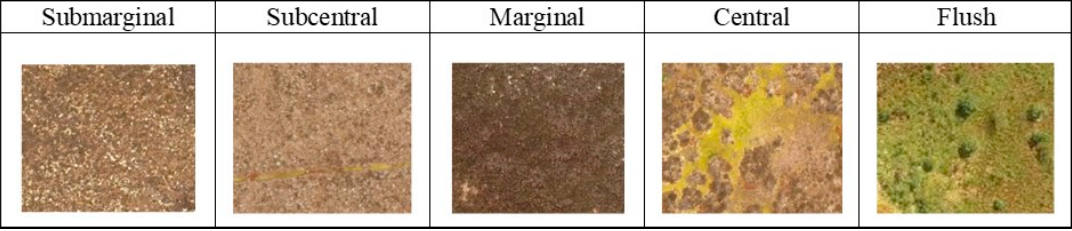
Table 1. Textural properties calculated using drone imagery.